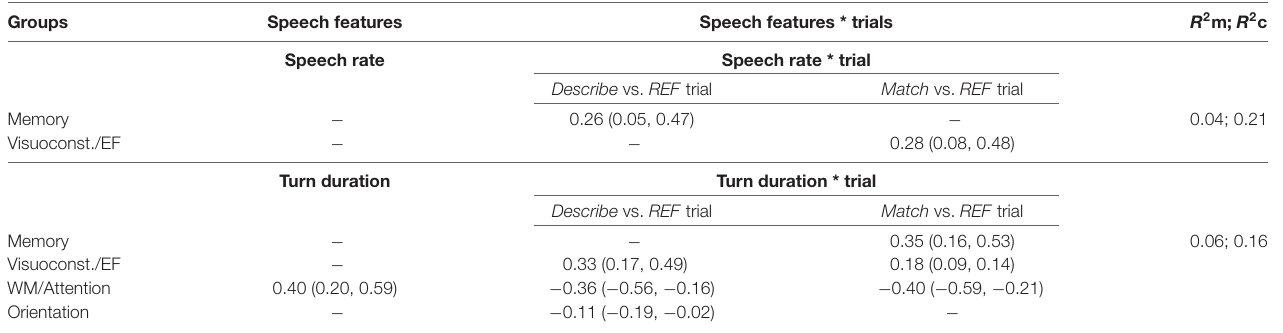
TABLE 4 | Coefficients and 95% confidence intervals with marginal and conditional R 2 for the observed significant associations between the speech features and the cognitive domains (composite scores; p <